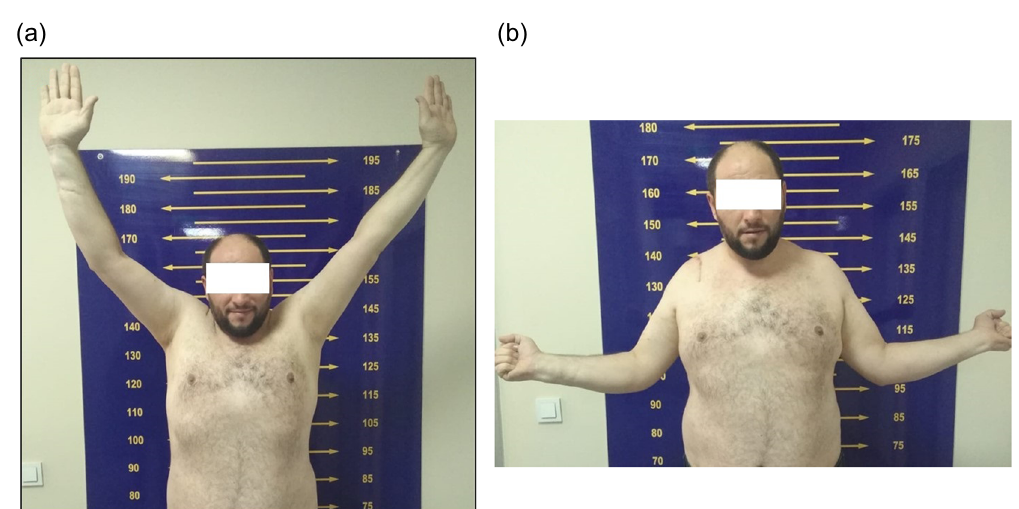
Figure 3. (a and b) Postoperative physical examination show good results.